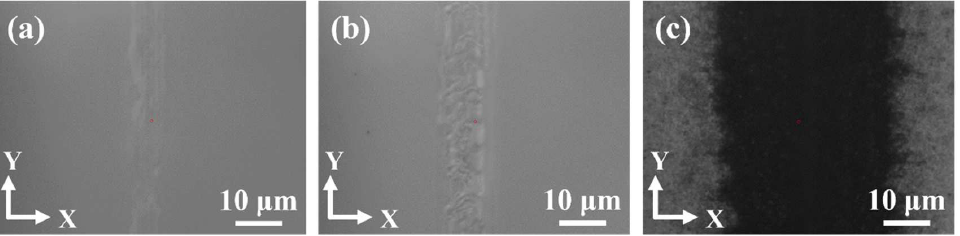
Figure 2. The optical images of SiC wafer surface with the various pulse energies of ( a ) 45 μJ, ( b ) 90 μJ, and ( c ) 180 μJ. and ( c ) 180 µ